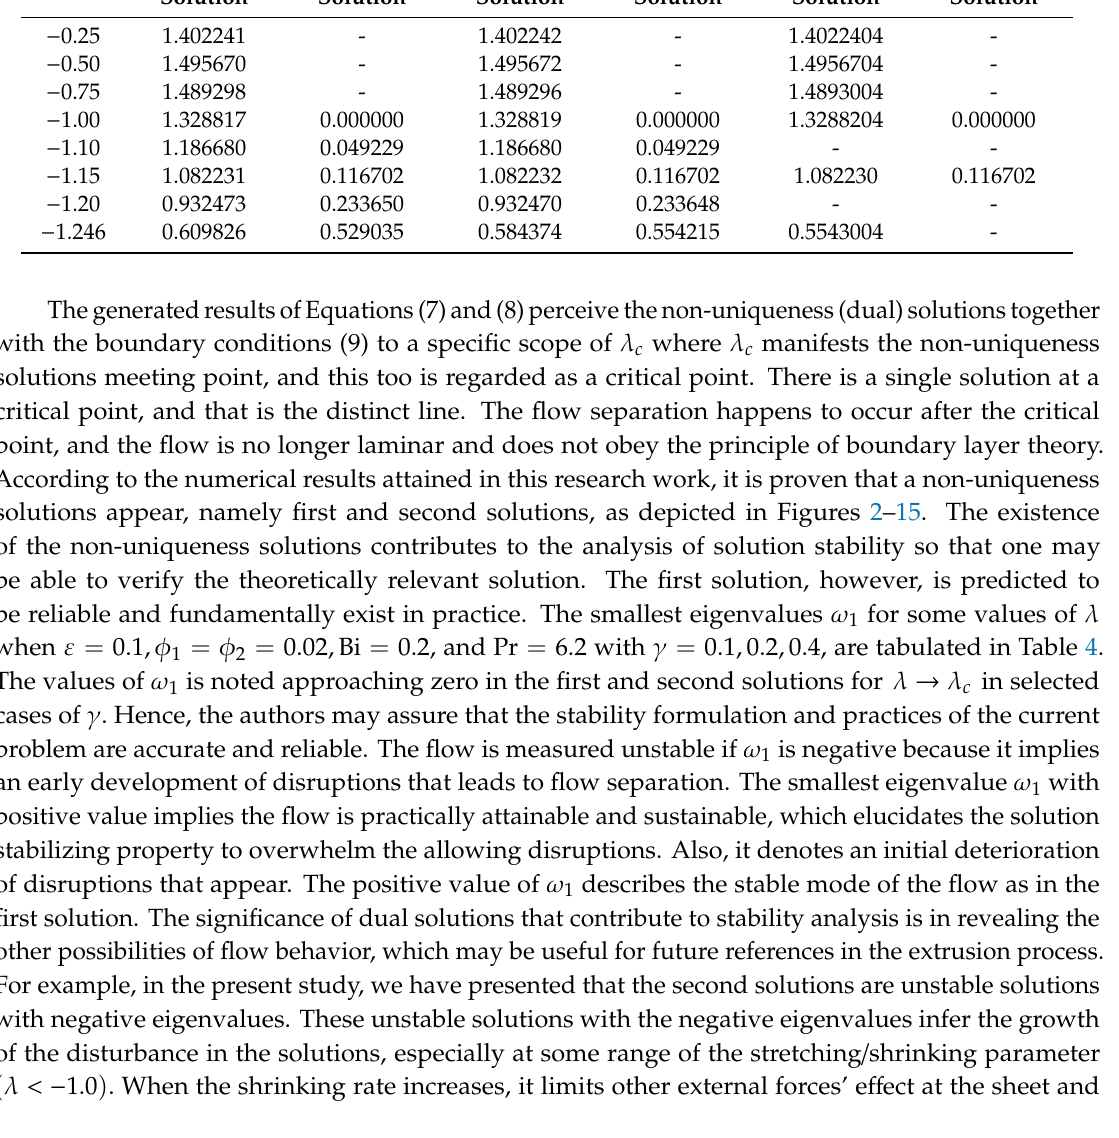
Table 3. Evaluation values of f (cid:48)(cid:48) ( 0 ) when ε = γ = Bi = 0, by certain values of λ . Present Result Mahapatra and Nandy [34] Wang [58] λ First